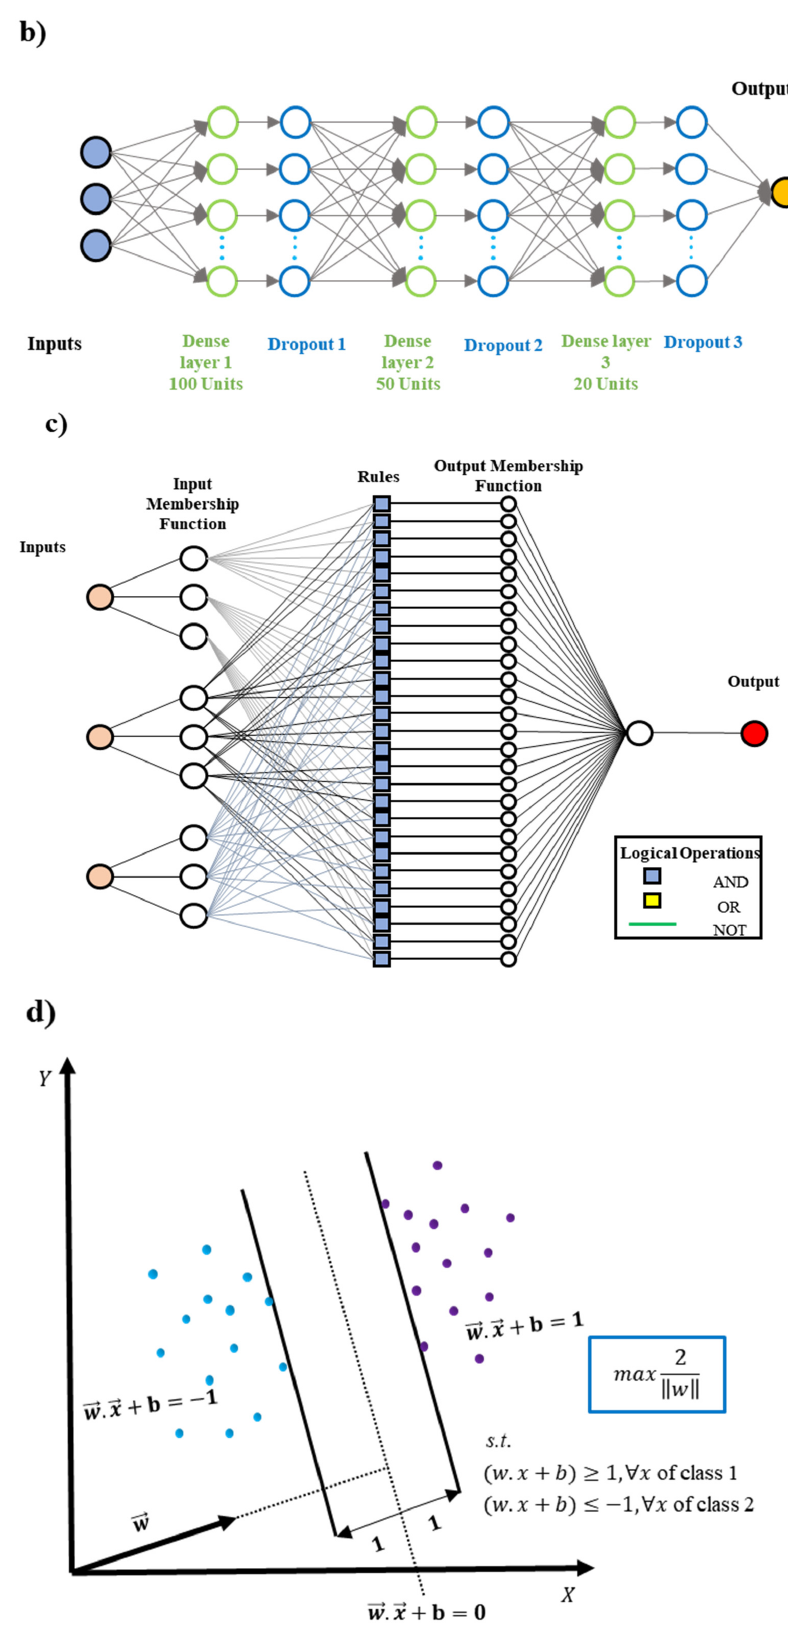
Figure 2. Representation of machine learning models: ( a ) ANN, ( b ) DNN, ( c ) ANFIS, and ( d ) SVM [104] .